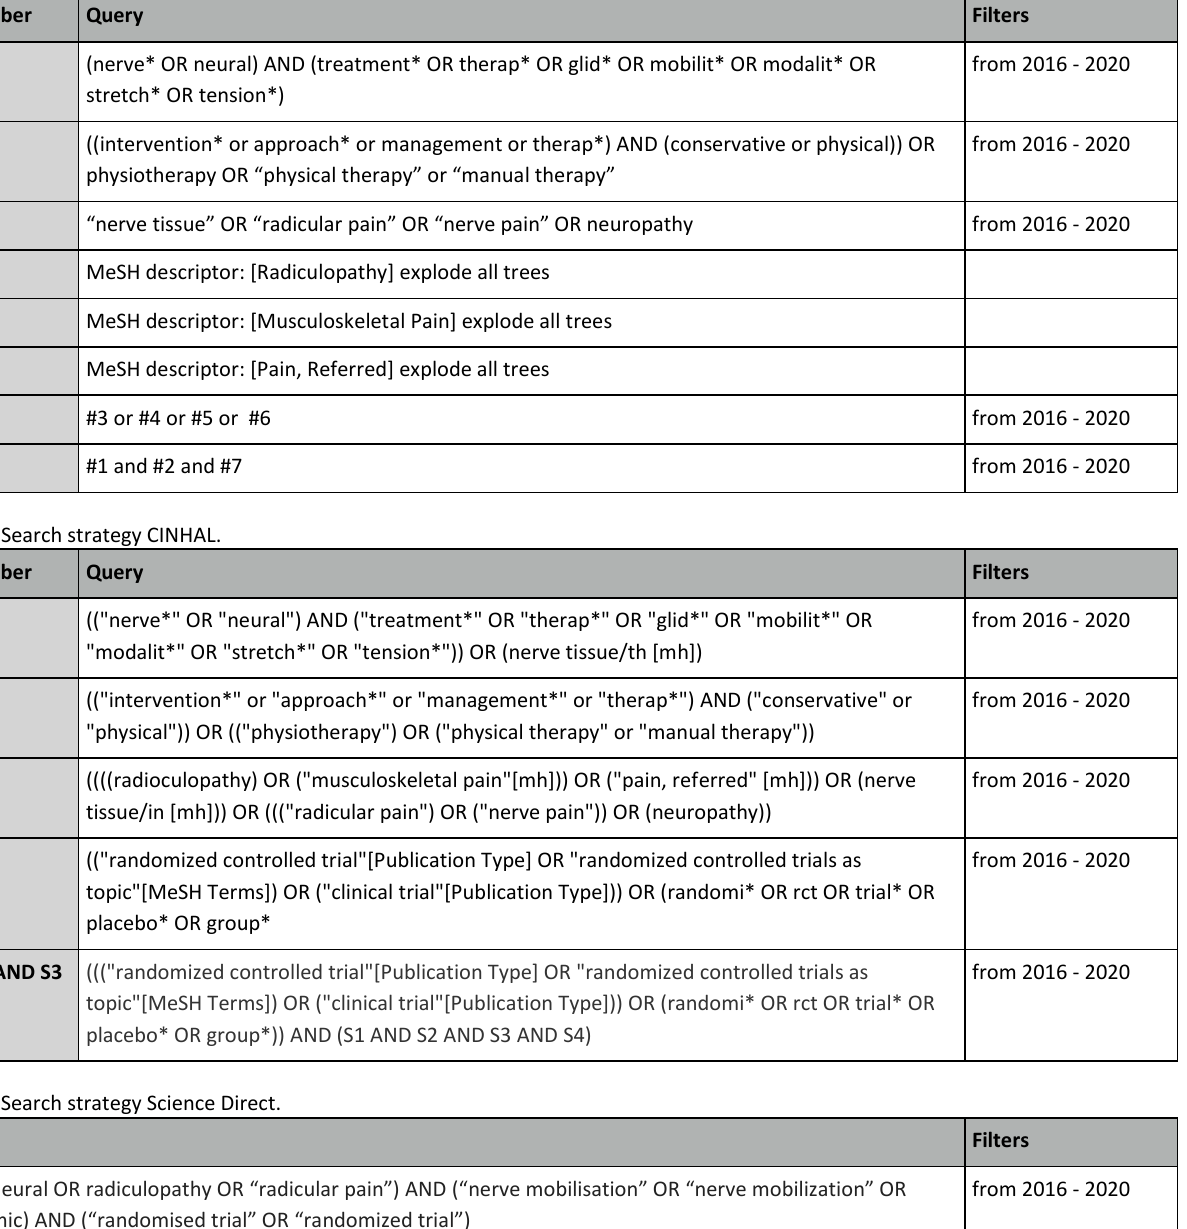
TABLE 3-A1: Search strategy Cochrane Controlled Trials Register.